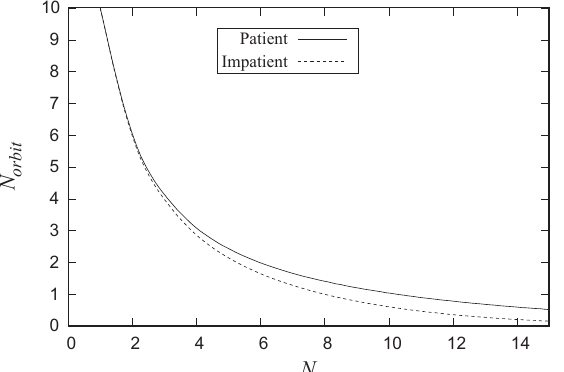
Figure 5. Dependence of the average number N orbit on the number N